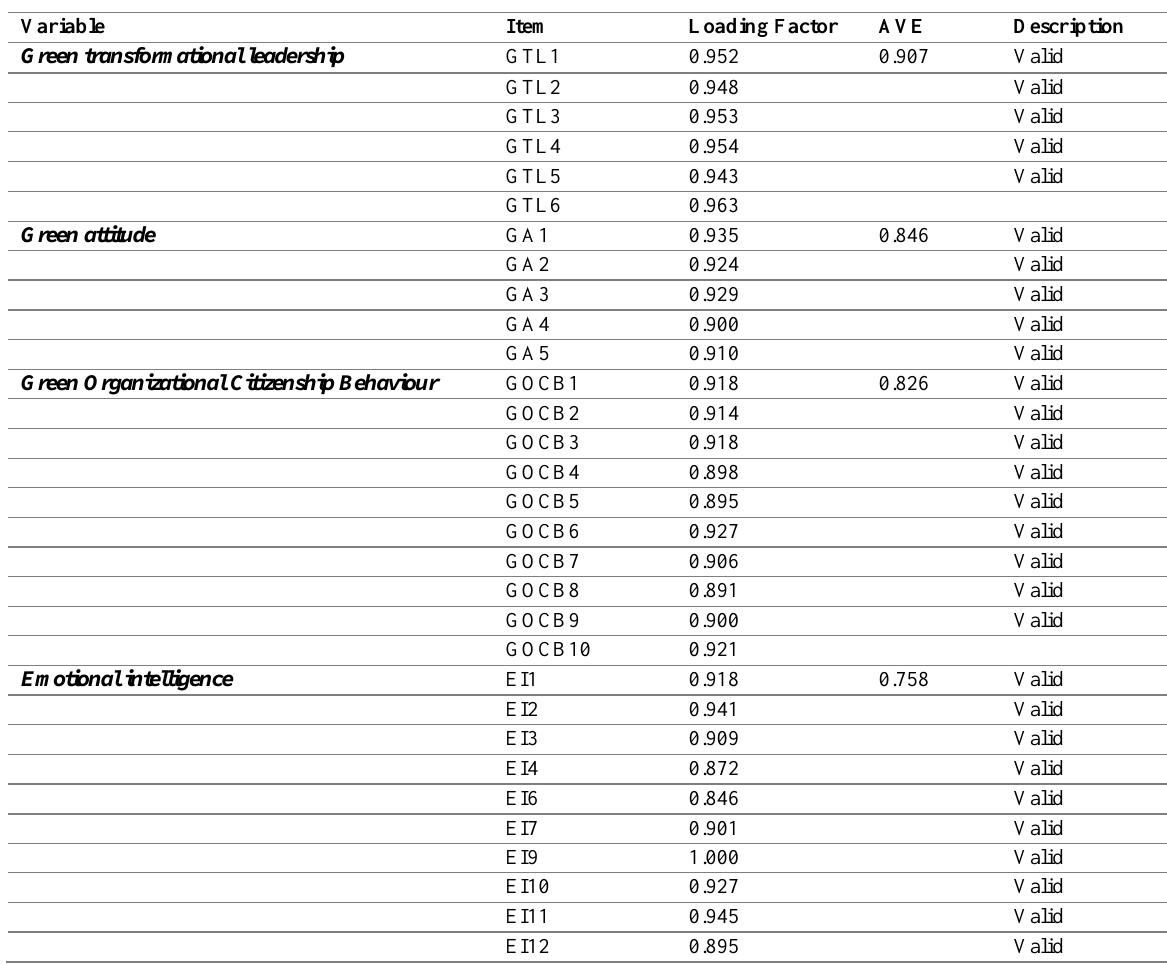
Table 2: Construct Loading Factor Values After